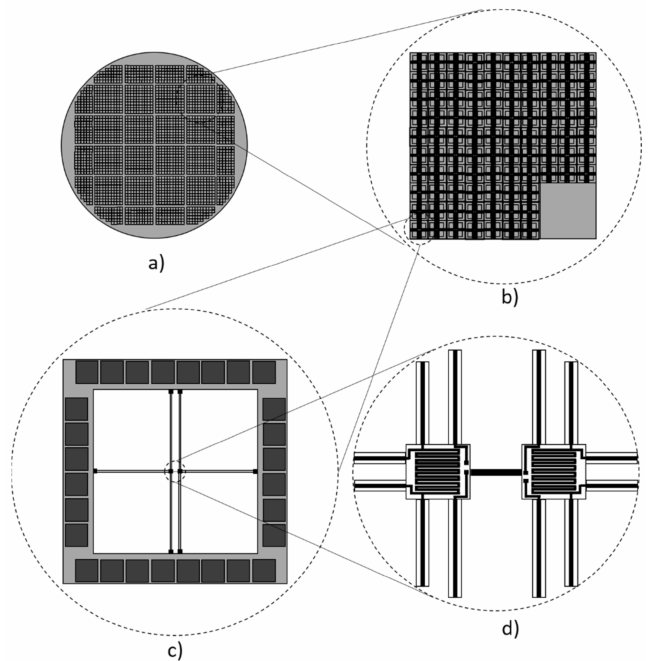
Figure 1. Schematic of the layout concept of microdevices with suspended platforms for manufac- turing out of one 4” bulk- and SOI wafer. ( a ) Arrangement of units on the wafer. ( b ) Regular unit with microdevices. ( c ) Single microdevice. ( d ) Two platforms with a silicon beam in between and supporting